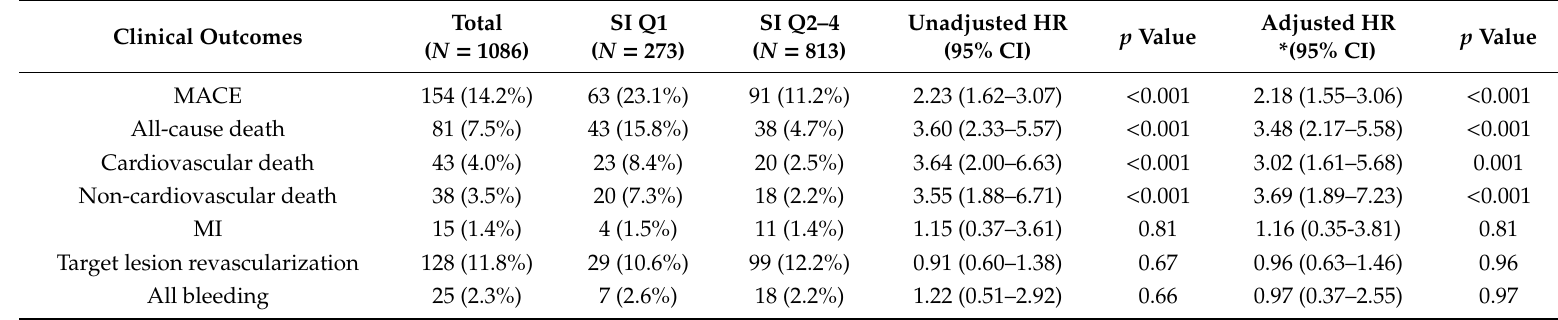
Table 2. Risk of clinical outcomes in patients with the lowest quartile (Quartile 1) of the SI compared with upper quartiles (Quartile 2–4) of the SI. Clinical